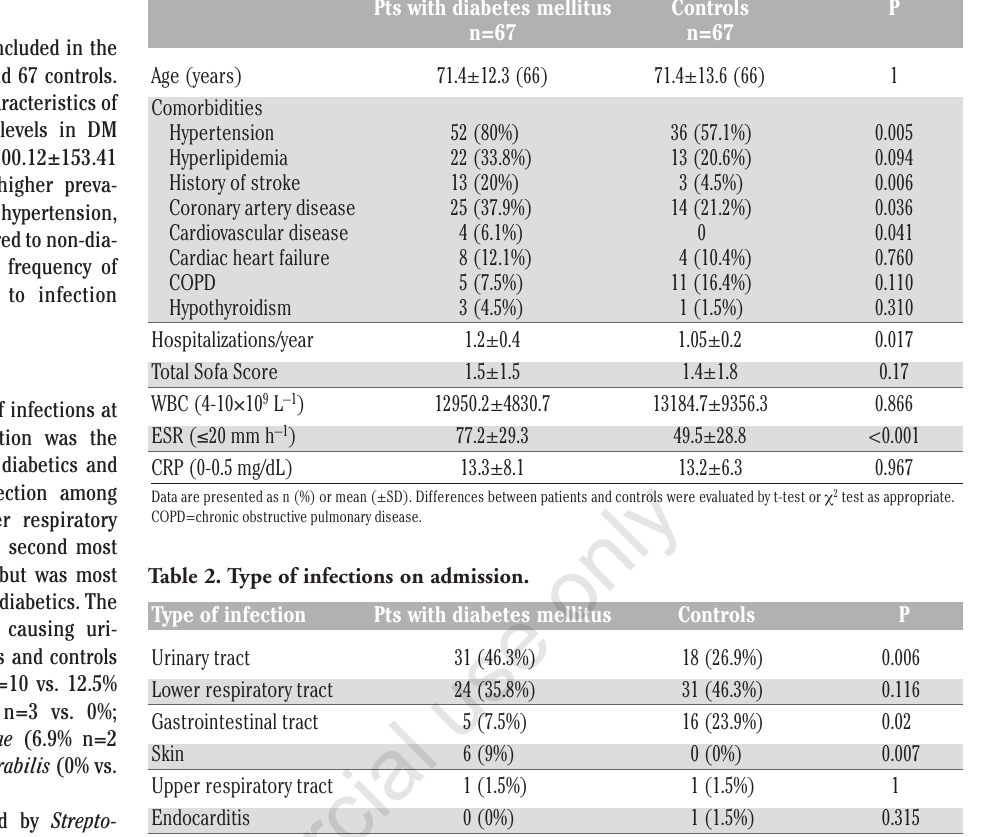
Table 1. Baseline characteristics of diabetic patients and controls included in the study. Pts with diabetes mellitus